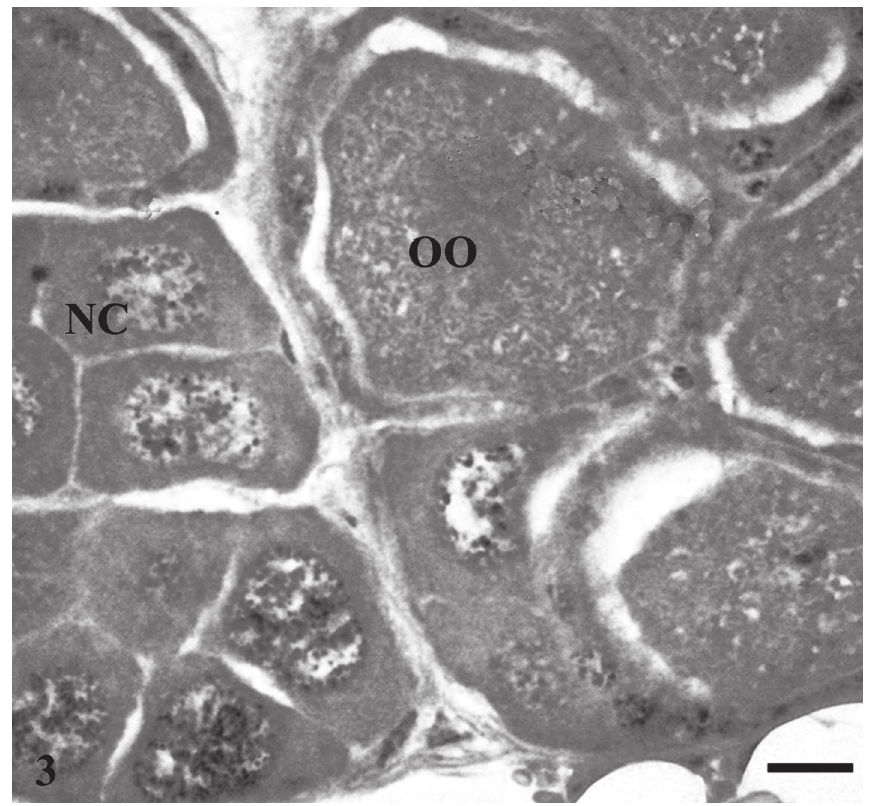
Figure 3 - Yolk accumulation in the oocytes (OO) of females of Palmistichus elaeisis (Hymenoptera: Eulophidae) after seven hours of their emergence from Tenebrio molitor (Coleoptera: Tenebrionidae) pupae. NC – nurse cells. Bar: